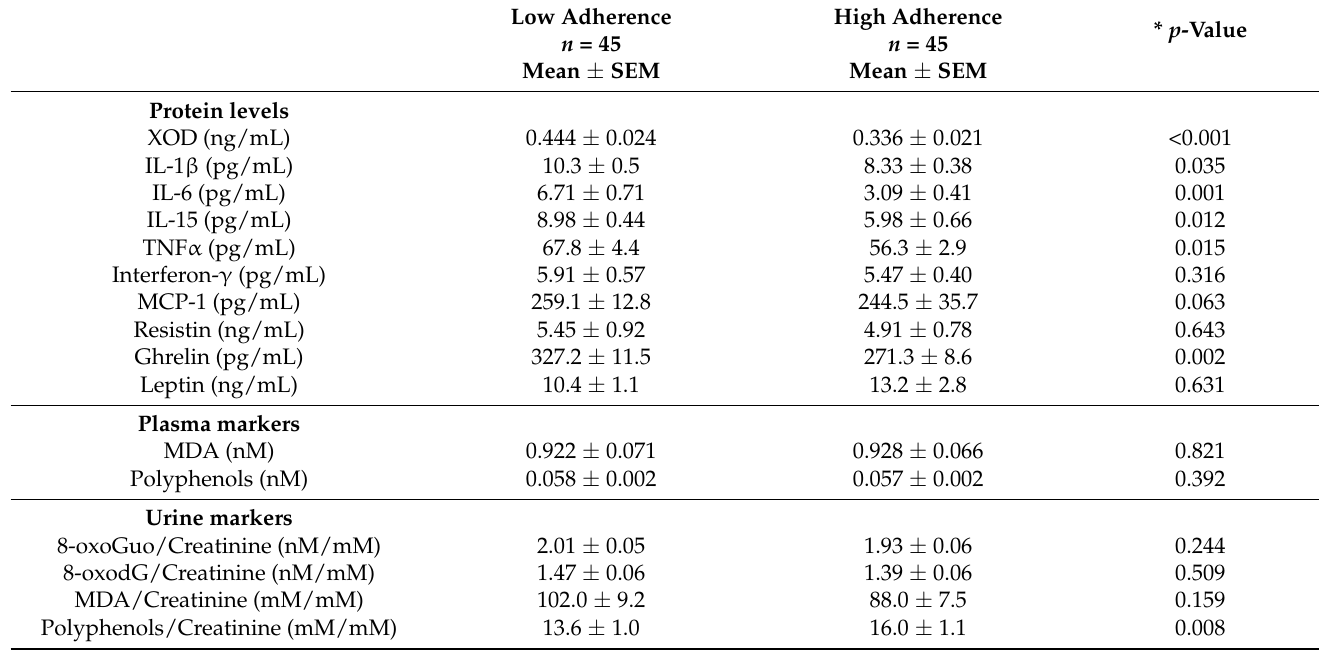
Table 4. Oxidative stress and inflammatory plasma markers of participants according to the median values of adherence Mediterranean Diet Pattern.